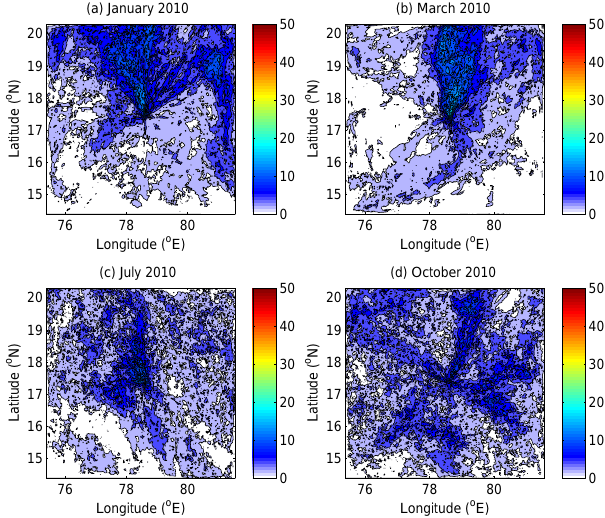
Figure 8. Spatial plot of probability (%) of occurrence of a BC peak within the altitude band of 4–5km for the model simulations carried out during (a) January 2010, (b) March 2010, (c) July 2010 and (d) October 2010.